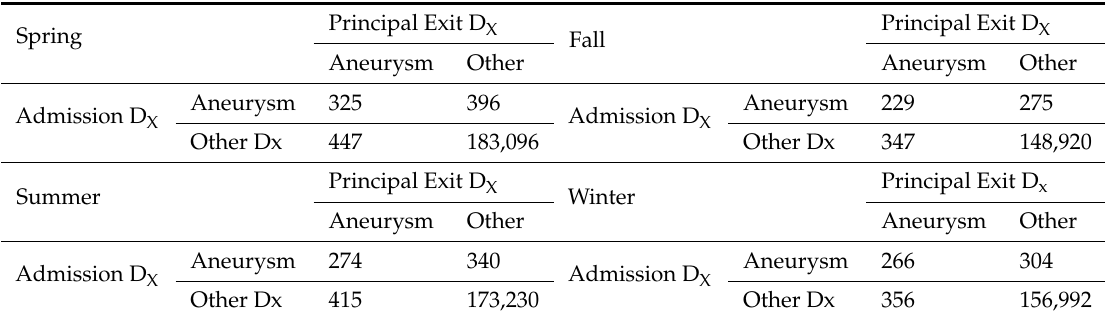
Table 5. Confusion matrices for the admission → discharge discrepancies of